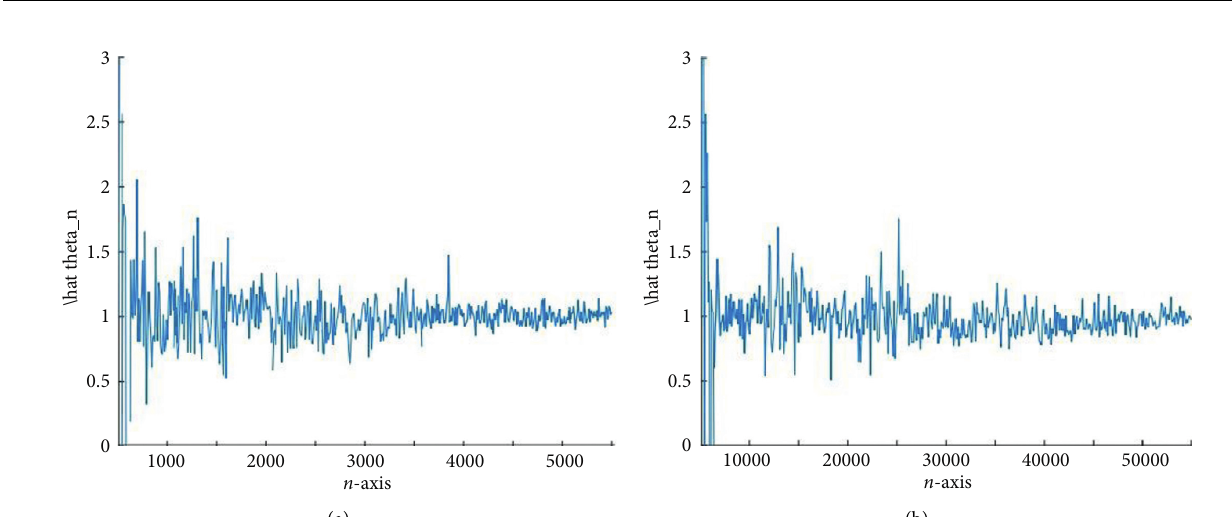
Figure 1: The simulation of the estimator 􏽢 θ